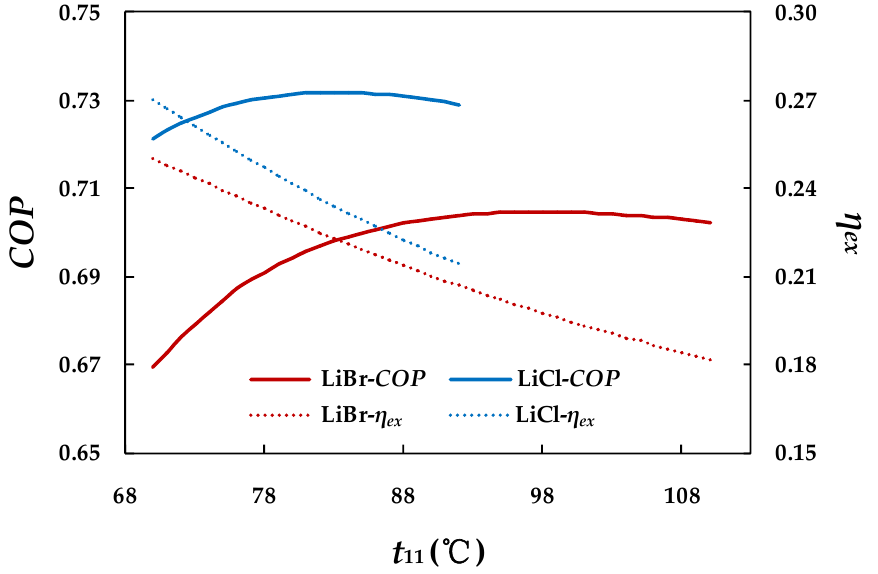
Figure 13. Variation of COP and exergy e ffi ciency with the hot water inlet temperature for the two absorption chillers.